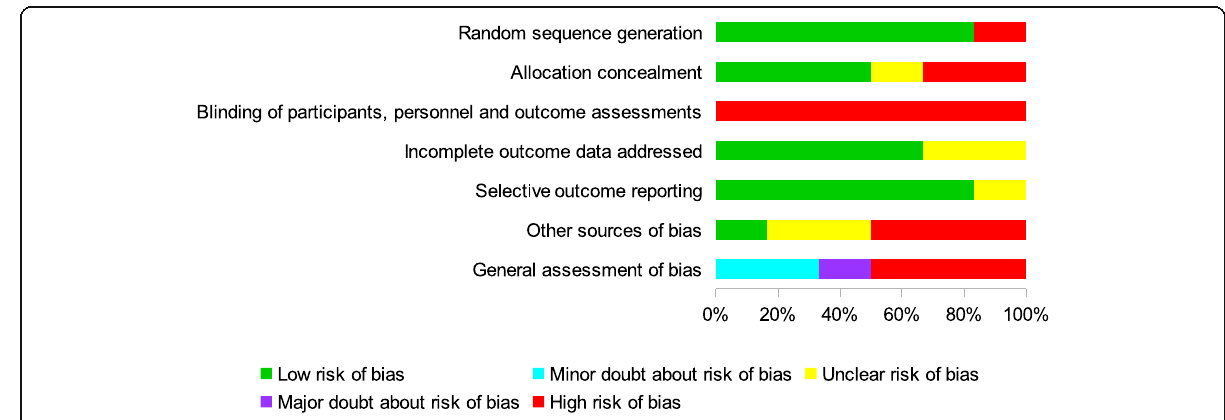
Fig. 6 Assessment of methodological risk of bias for the efficacy studies taken together. Green shading indicates a low risk of bias, yellow an unclear risk of bias and red a high risk. Grey shading color indicates non-applicable items. For general assessment of bias, purple shading and cyan shading indicates a major doubt and a minor doubt as to the overall risk of bias,